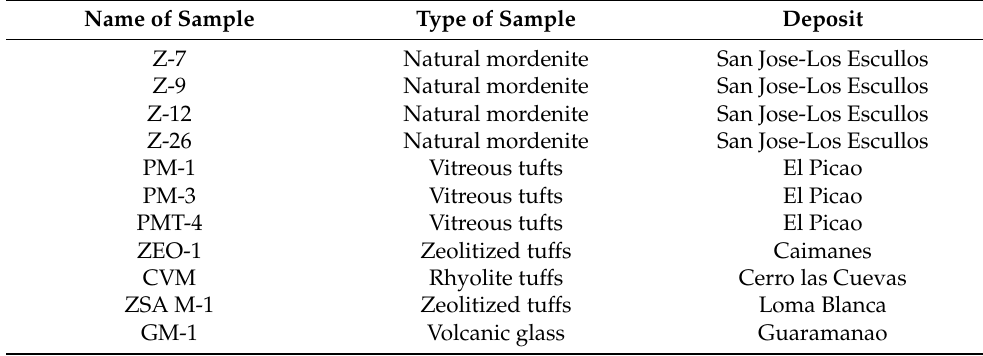
Table 1. Name, nature, and origin of pozzolanic additions